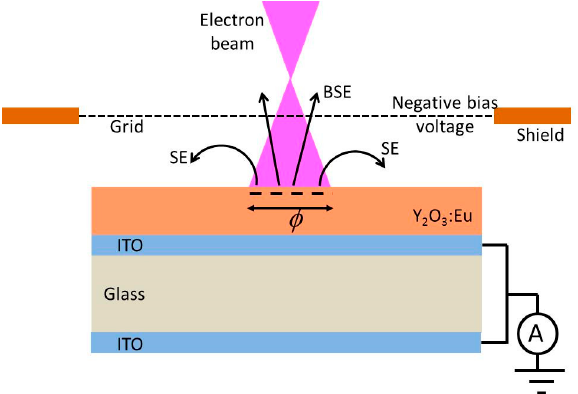
Figure 2. Over-focused e-beam hits Y 2 O 3 :Eu 3+ phosphor layer and generates negative charge. φ is the diameter of spot. BSEs pass the grid (at − 50 V), whereas SEs are deflected. Not all SEs are collected in the case of charging.